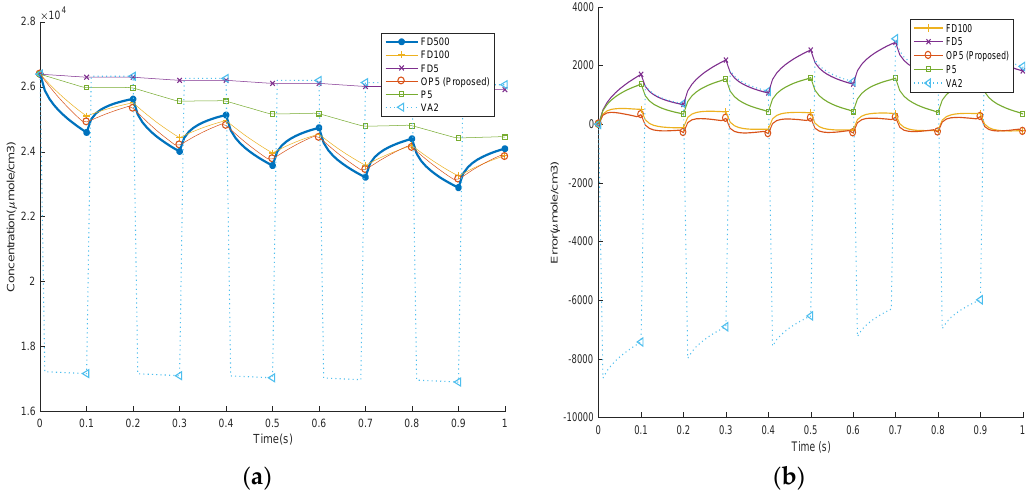
Figure 12. Time domain outputs of different methods for 5 Hz pulses ( a ), errors of different methods compared to FD with 500 nodes ( b